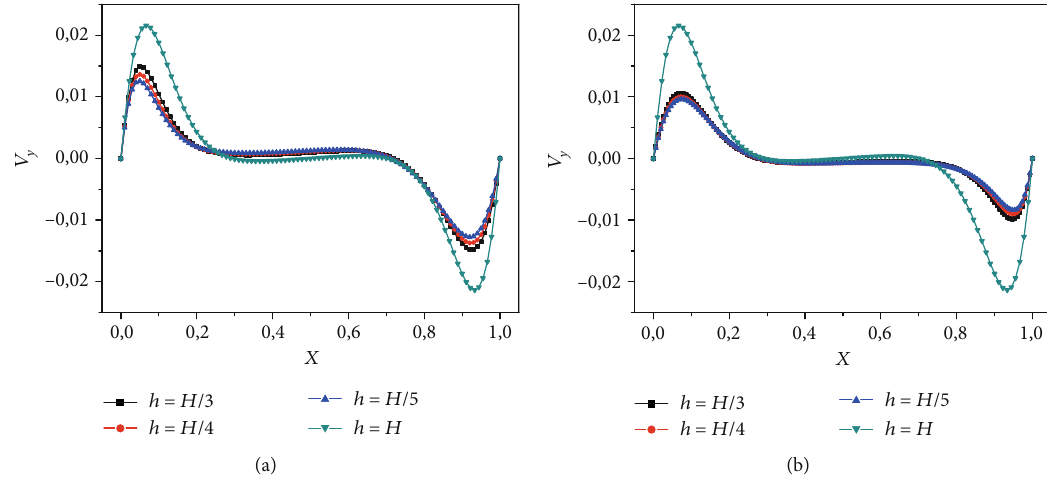
Figure 9: y -component velocity pro fi les for Ra = 10 5 and for di ff erent hot (a)/cold (b) chip lengths ( h = H , H /3, H /4 , and h = H /5